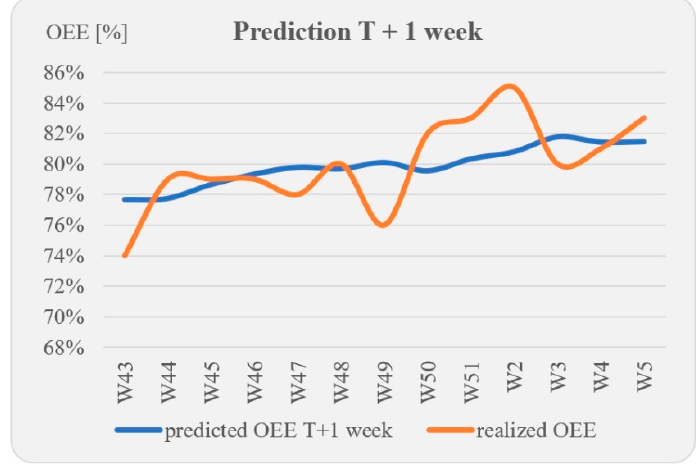
Figure 9. Predicted and realized OEE values. Table 7. Descriptive statistics for target-oriented OEE prediction based on decision tree.